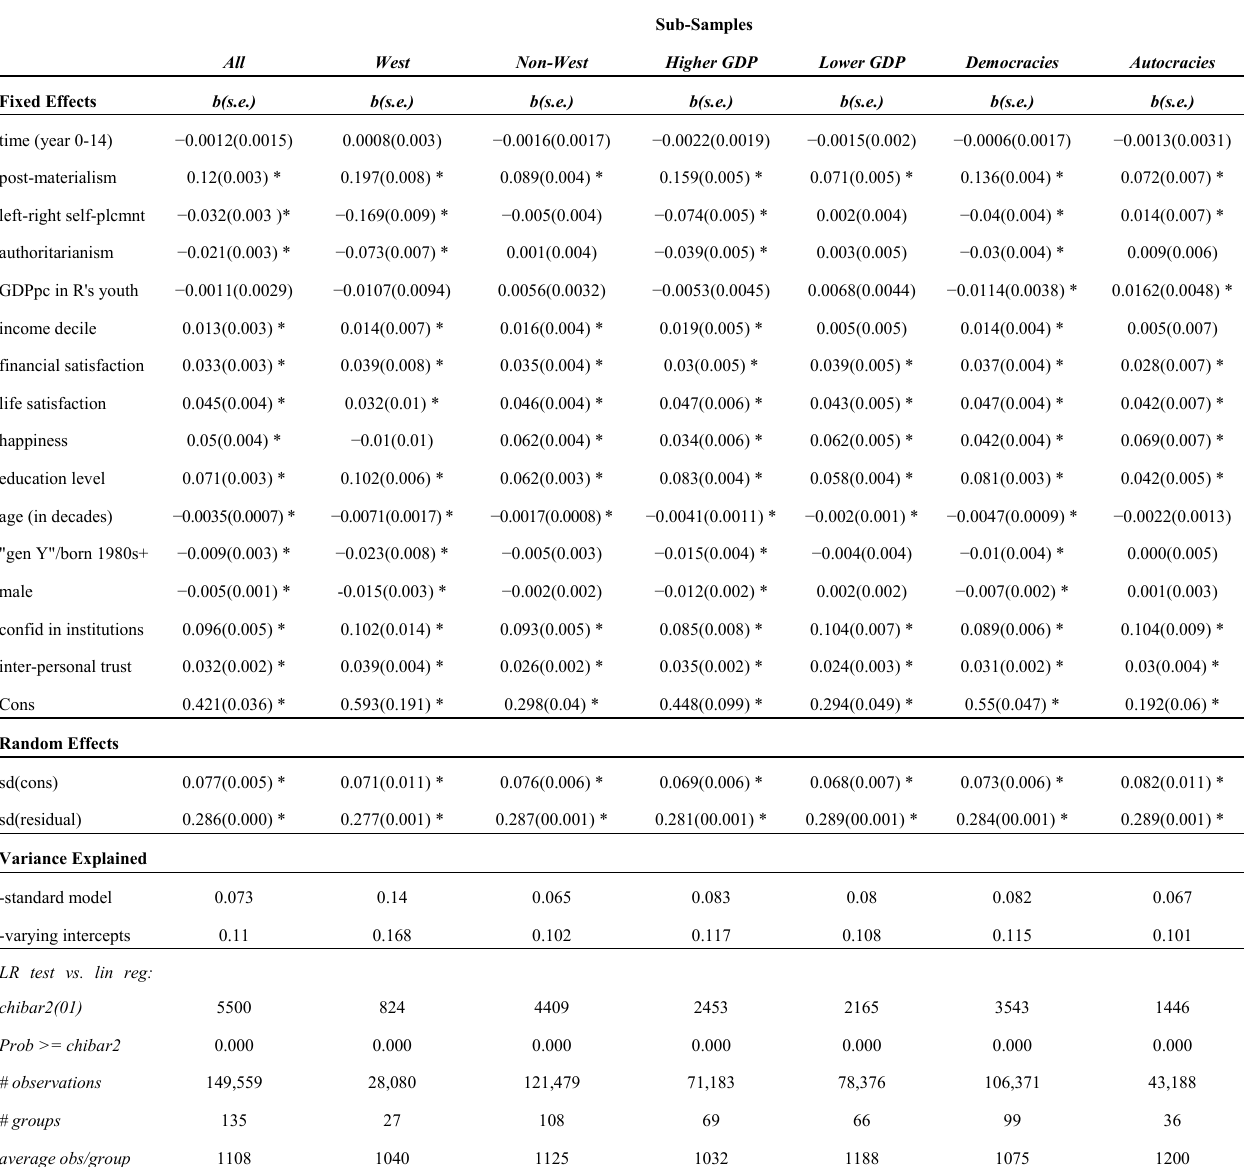
Table 2. Determinants of public support for environmental protection, across